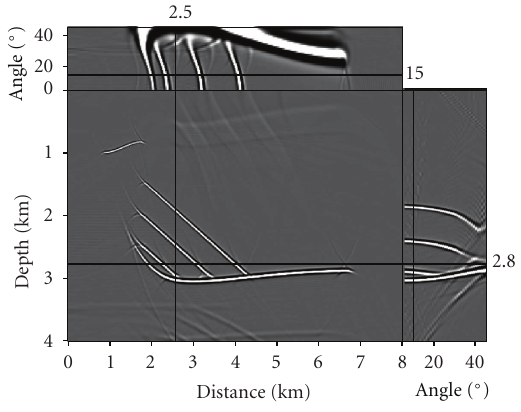
Figure 6: Migrated section after a VTI migration with velocity of 2km/s and η = 0 . 2 of the TTI synthetic data in Figure 4. Again, the angle gathers obtained using an isotropic mapping at 8km location are displayed on the right, and the top section shows a depth slice as a function of angle gather at depth 2 km.